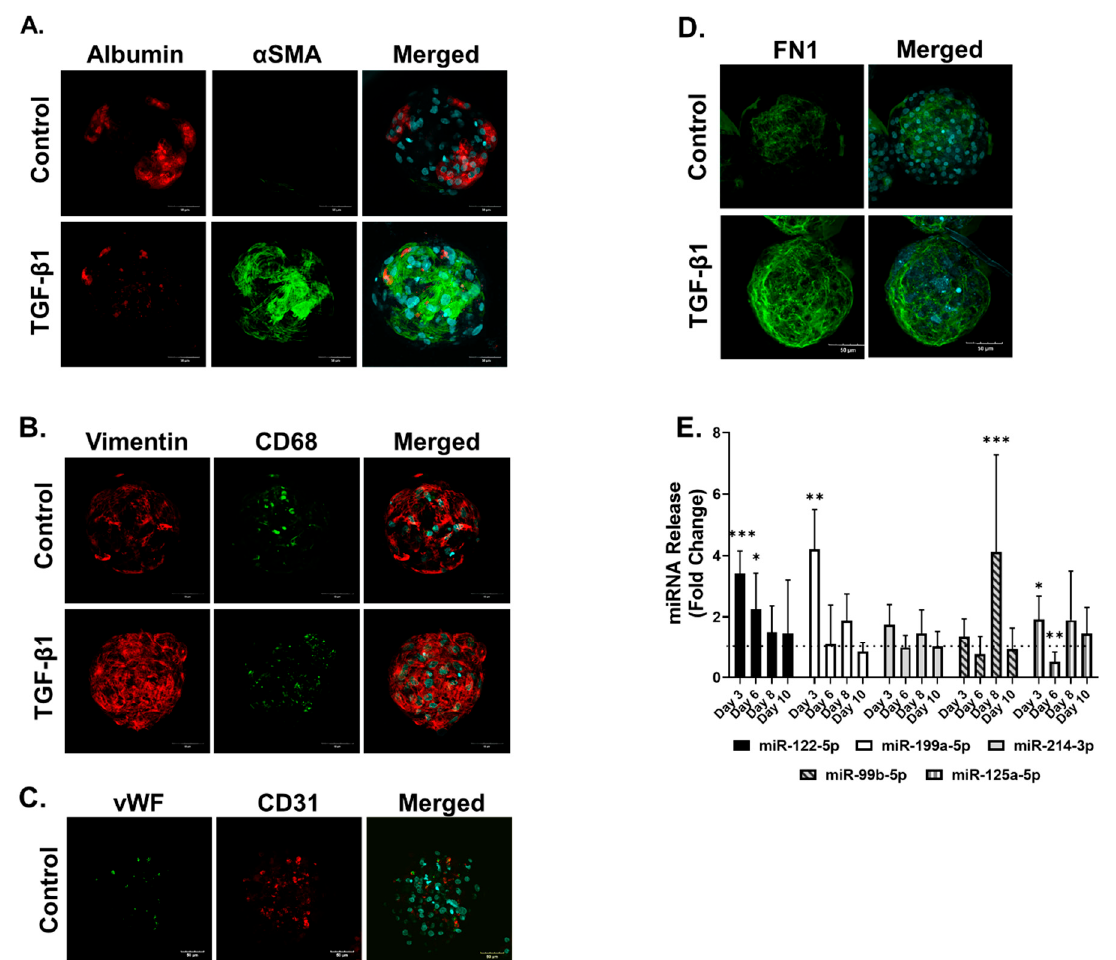
Figure 6. Measurement of miRNAs in primary MTs exposed to TGF- β 1. Primary MTs were left untreated or exposed to TGF- β 1 for 3-10 days. Primary MTs were fixed at day 10 and co-stained for α SMA and albumin ( A ), vimentin and CD68 ( B ), CD31 and vWF ( C ) and FN1 ( D ), and counterstained with DAPI. Cell culture supernatant was collected over 10 days to investigate miRNA release of primary MTs exposed to TGF- β 1 using q-RT-PCR. miRNAs measured included: miR-122-5p, miR-199a-5p, miR-214-3p, miR-99b-5p and miR-125a-5p, which were measured at day 3, day 6, day 8 and day 10, and analyzed using q-RT-PCR ( E ). Data are expressed as fold change, n = 9. Bar graphs represent means ± SD; statistical analysis based on Student’s unpaired t test; *, p ≤ 0.05; **, p ≤ 0.01; ***, p ≤ 0.001.